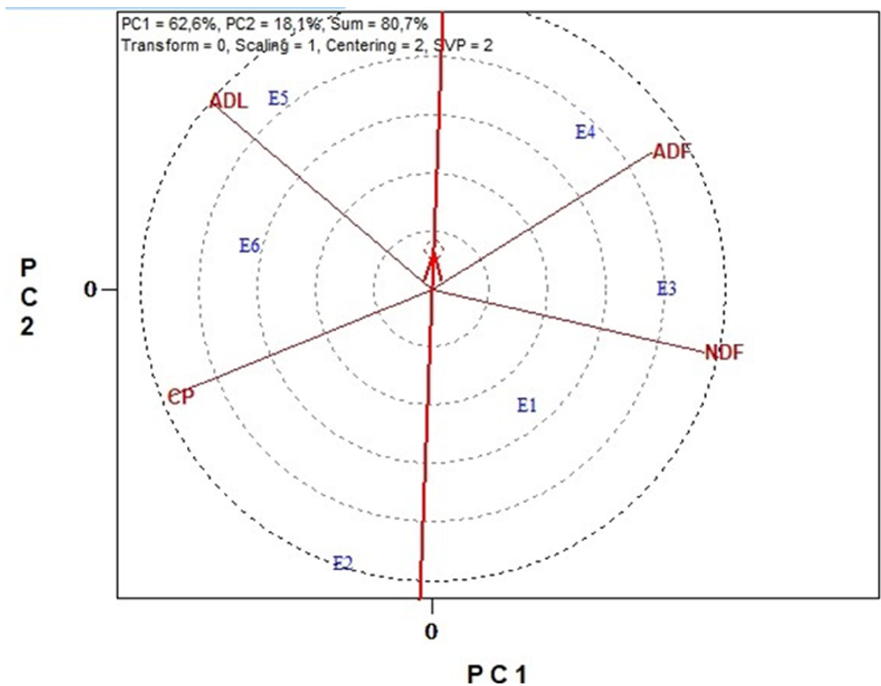
Figure 6. The “Discrimitiveness vs. representativeness” view of the GGE biplot for six testing environments of four nutritional traits, averaged across seven genotypes of V. sativa.